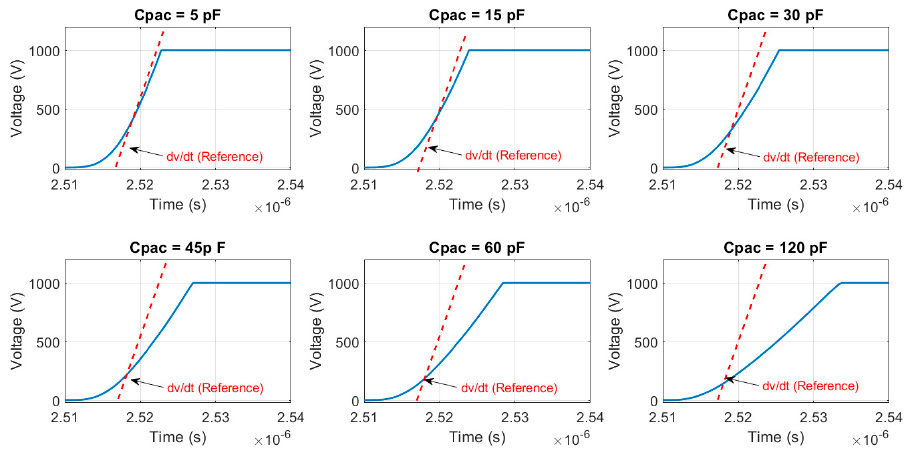
Figure 6. Simulation results of the middle point switching speed as a function of C pac for the classical packaging/layout.